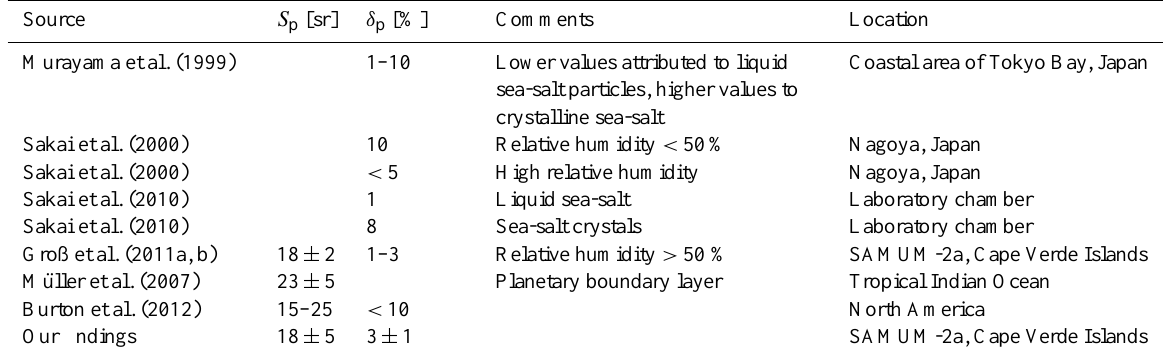
Table 7. Summary of the key findings concerning the lidar ratio ( S p ) and the particle linear depolarization ratio ( δ p ) found for marine aerosols.